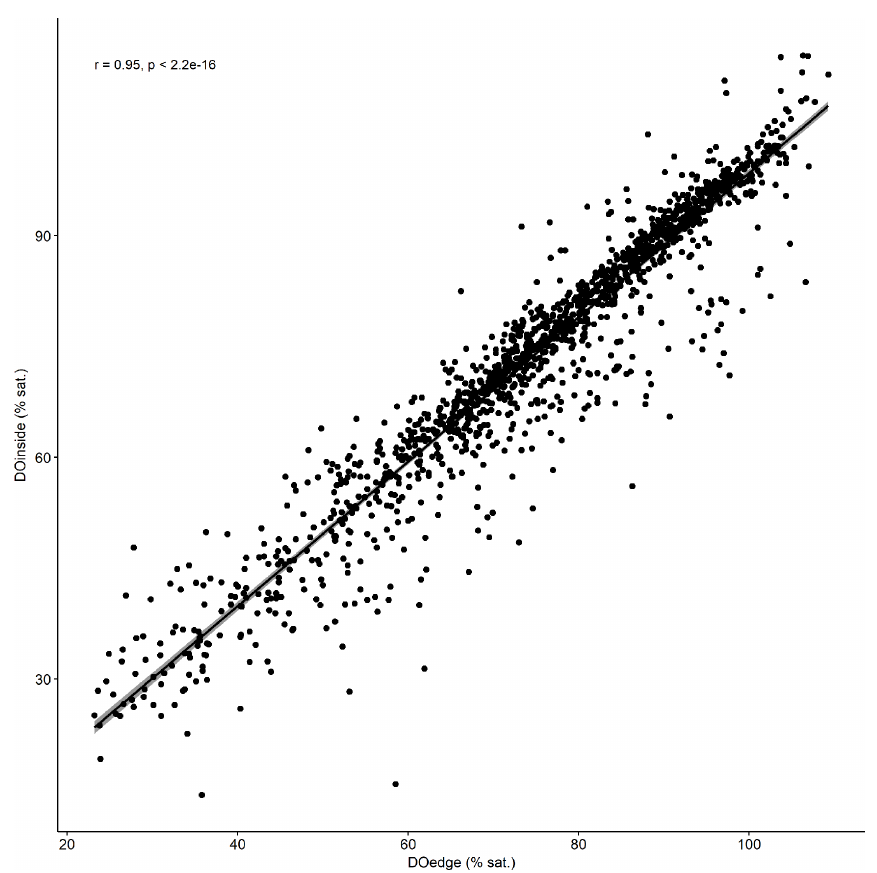
Figure A1. Kendall’s correlation test used to determine whether patterns of change in DO were significantly correlated between edge and in-forest sites. DOedge: DO recorded in edge sites; DOinside: DO recorded in in-forest